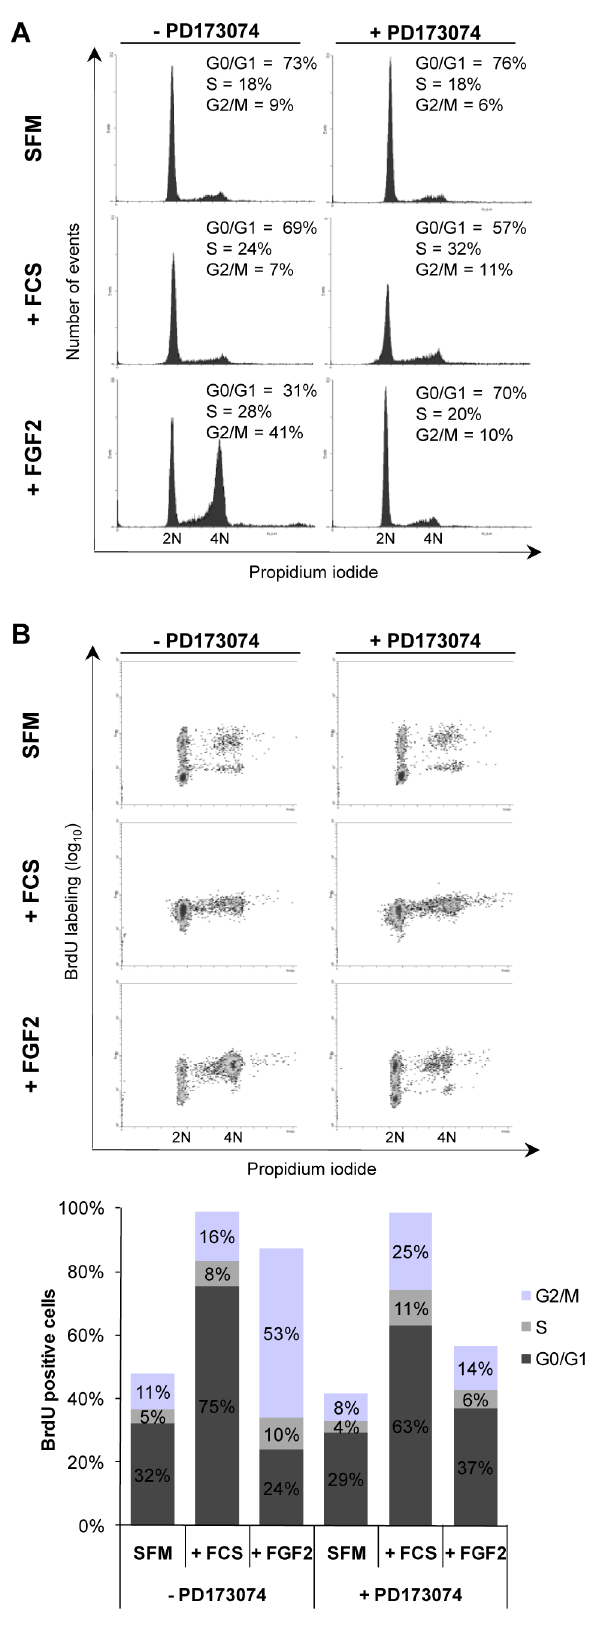
Figure 4. FGF2 causes G2/M arrest in Y1 cells. Flow cytometry histograms show DNA content in Y1 cells after 48 hours of FCS